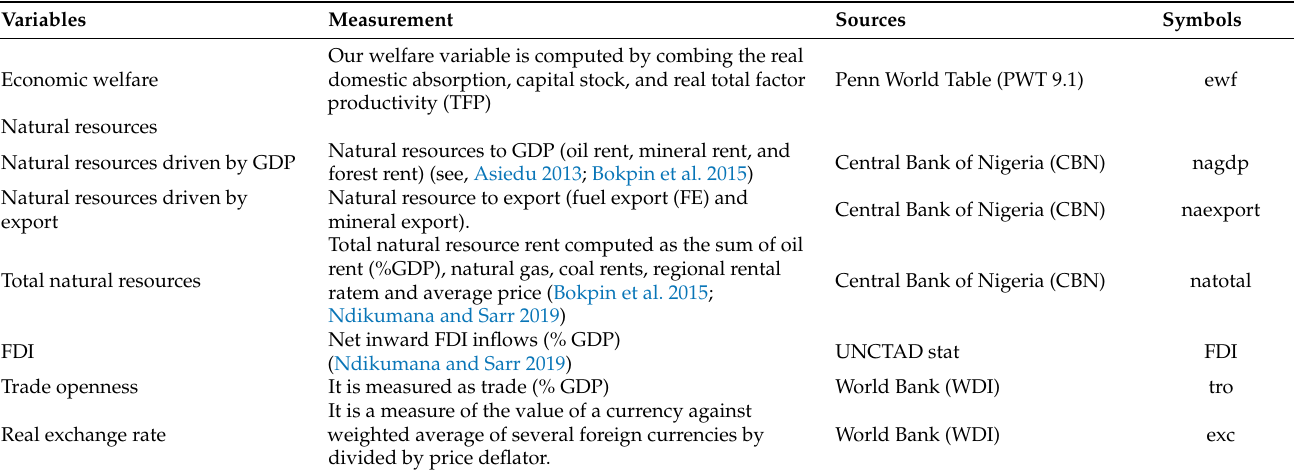
Table A1. Description of